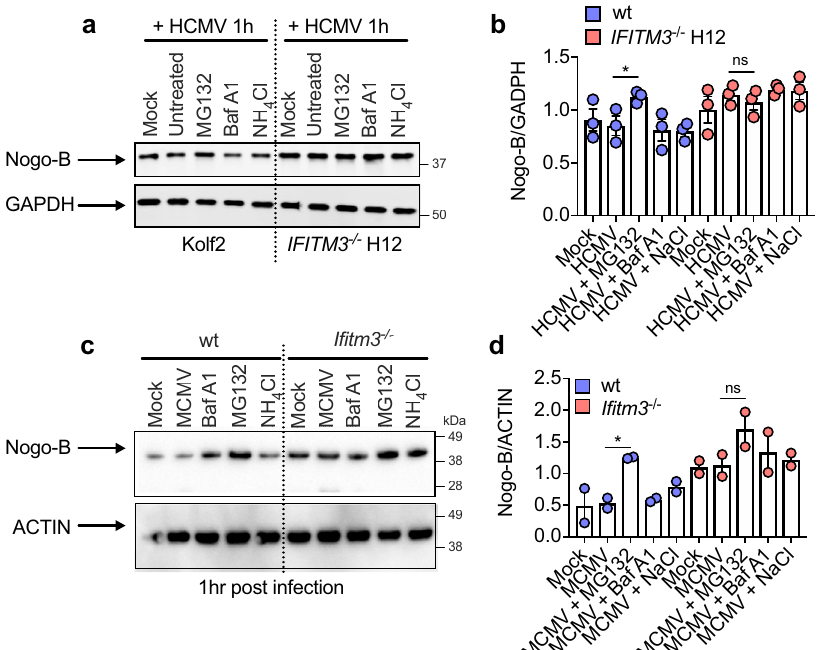
Fig. 6 | IFITM3 regulates Nogo-B expression via the ubiquitin-proteasome pathway. a , b Kolf2, IFITM3 − / − iPS-DCs or c , d BM-DCs (from two male donor mice/ group) were pre-treated with Ba fi lomycin A1, NH 4 Cl or MG132 for 1h, then stimu- latedwith ( a , b ) HCMV(iPS-DCs) (MOI 5)for1h orinfected with( c , d )MCMV (MOI 1) for 1h (BM-DCs). Nogo-B levels were assayed by Western blot ( a iPS-DCs, c BM-